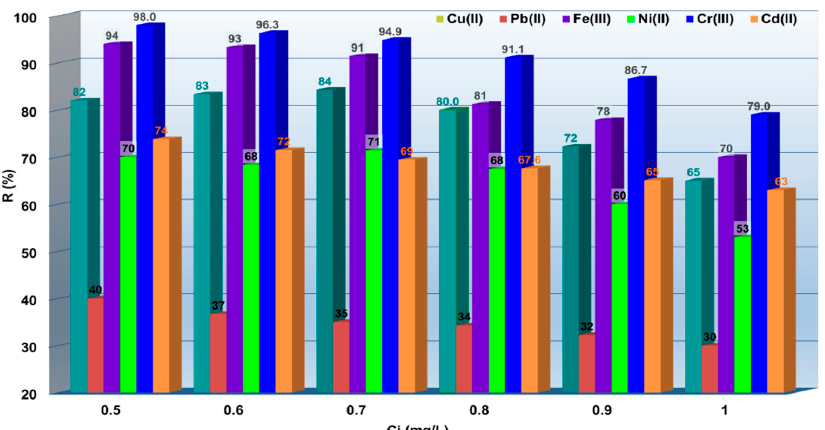
Figure 4. Removal of M X+ from simulated textile wastewater onto MS. Experimental conditions: Ci =0.5–1 mg/L M X+ , contact time 60 min, 175 rpm, 0.5 g MS, pH = 4.2.